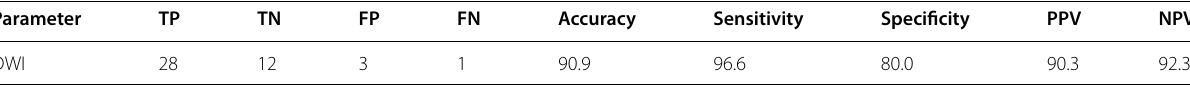
Table 1 DW-MRI: accuracy, sensitivity, specificity, PPV and NPV Parameter